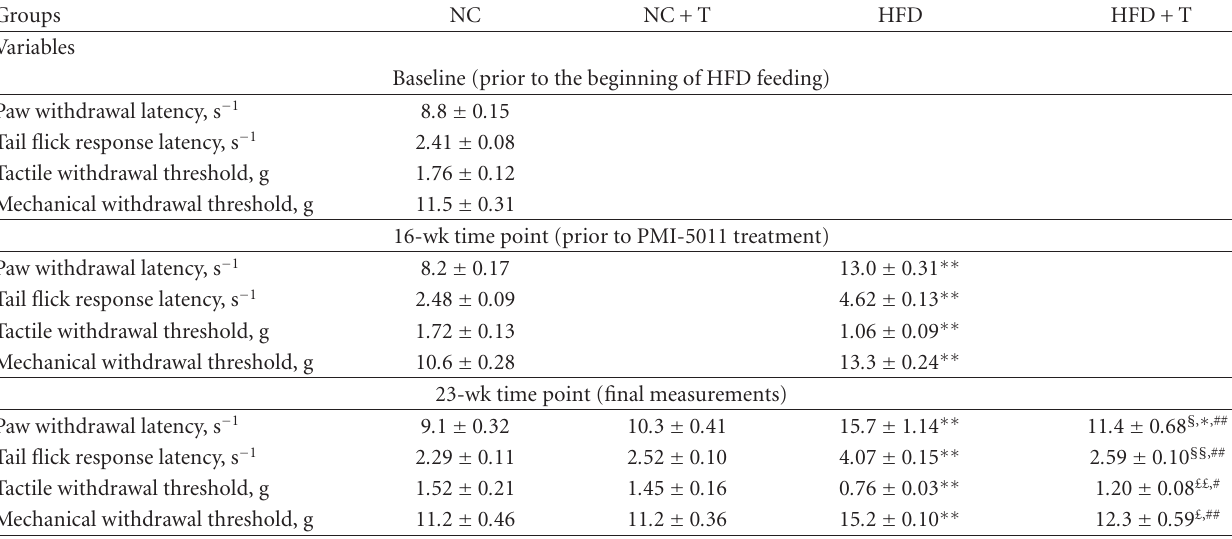
Table 3: Variables of small sensory fiber neuropathy in normal chow and high fat diet-fed mice maintained with and without PMI-5011